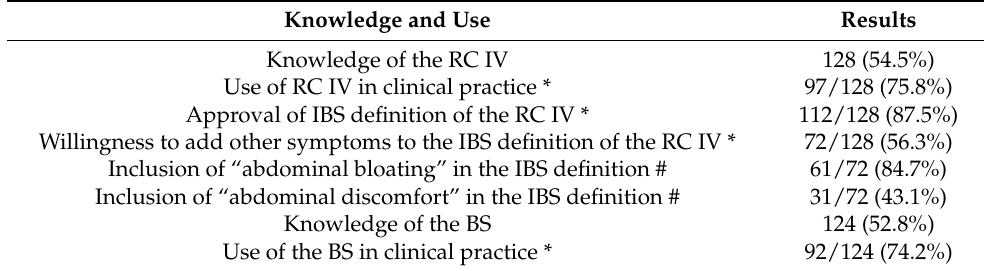
Table 4. Knowledge and use of the RC IV and the